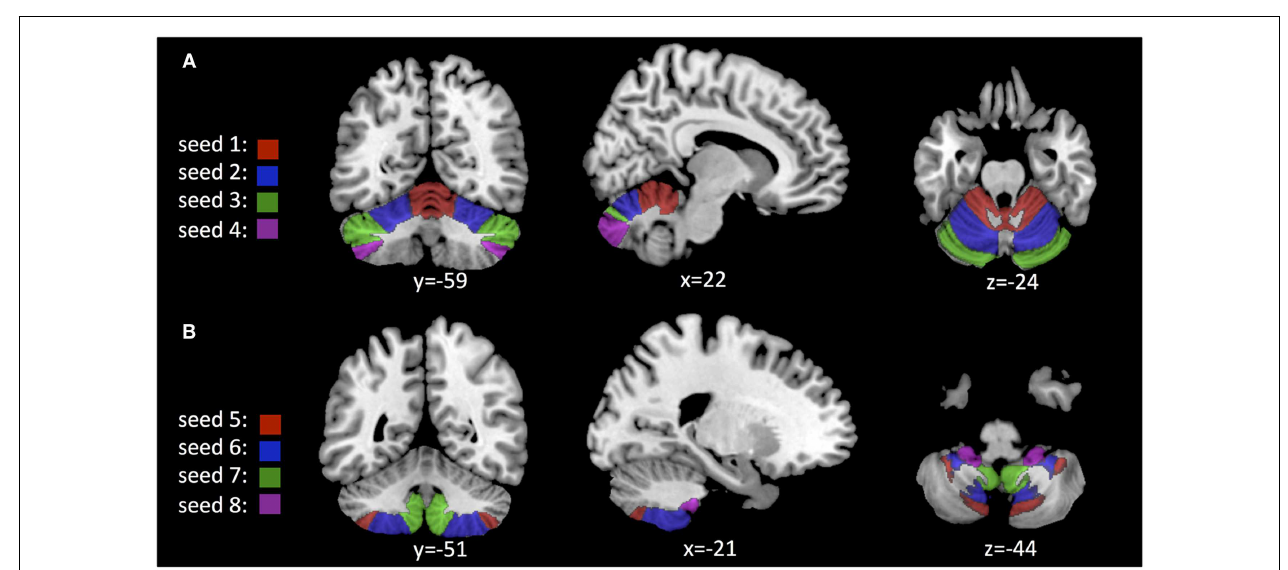
FIGURE 1 | Location of seeds used for analysis of cerebro-cerebellar coupling as derived from theAAL 3D MRI atlas (Schmahmann et al., 1999; Tzourio-Mazoyer et al., 2002): (A) Seeds #1–4, representing cerebellar lobules I–V;VI; crus 1; crus 2 . (B) Seeds #5–8, representing lobulesVIIb;VIII; IX; X.